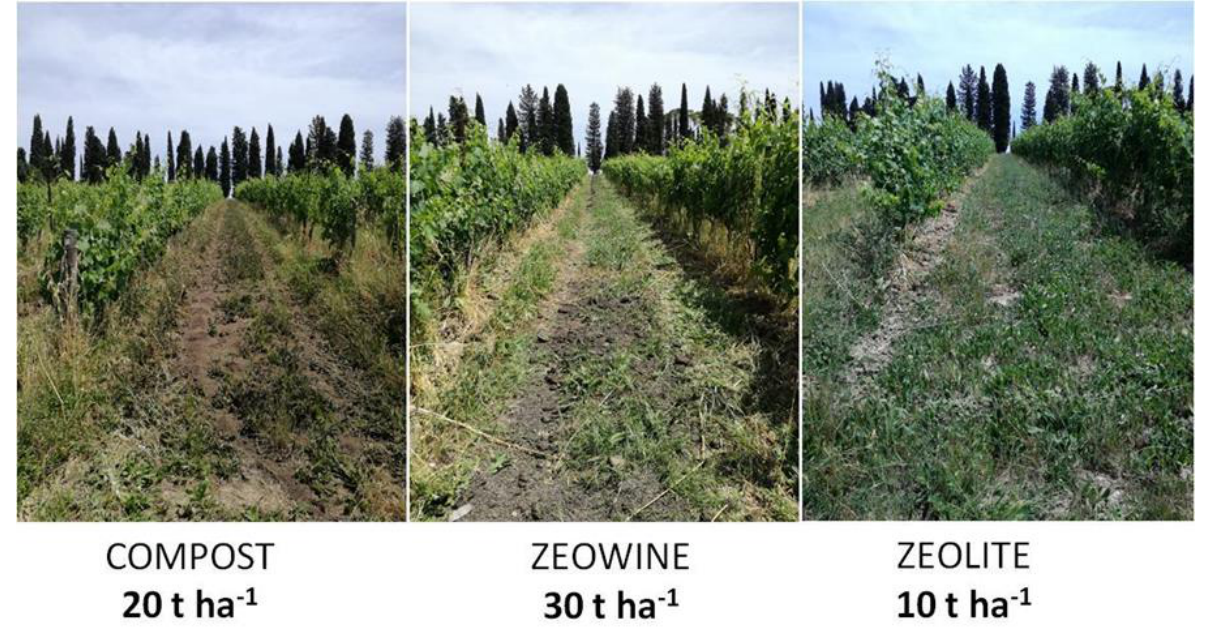
Figure 16. Treatment application results at CMM. The agro-meteorological system Pre-meteo (Mybatec S.R.L., NO, Italy) monitored the main parameters such as rainfall (mm) and air temperatures ( ◦